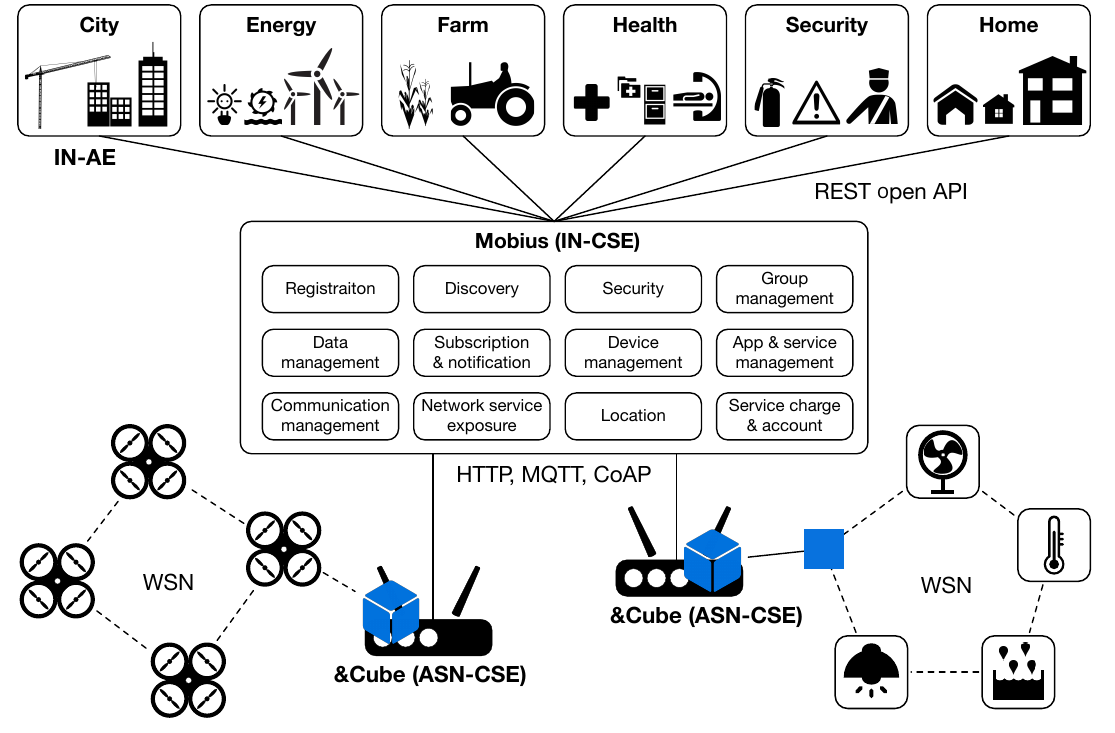
Figure 5. A block diagram of overall architecture and interface for an IoT system composed of our oneM2M standards-compliant platforms (Mobius and